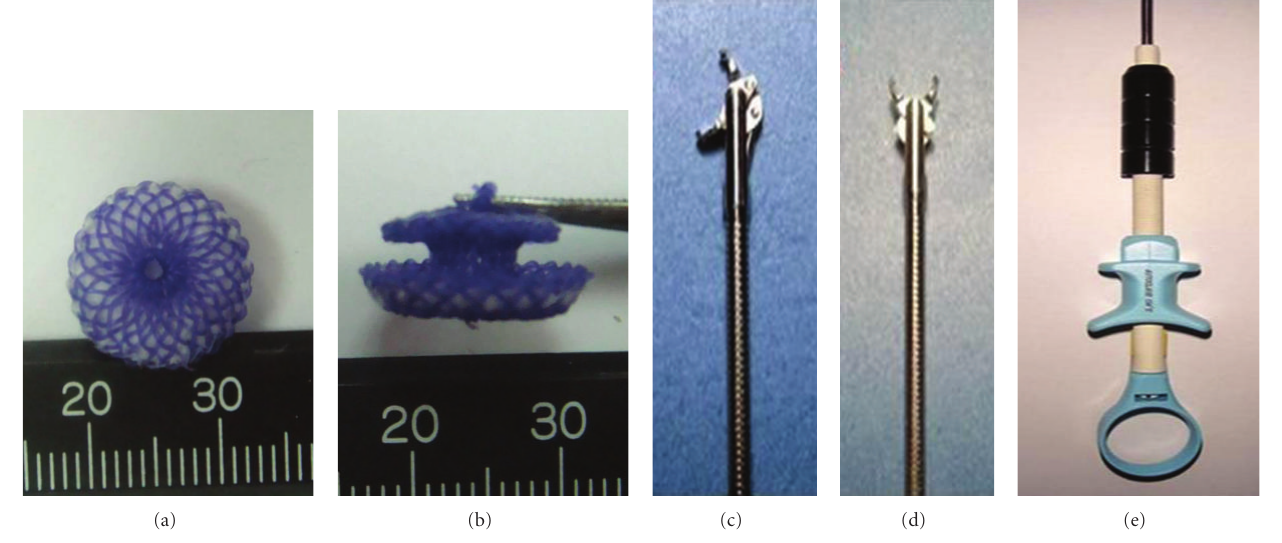
Figure 1: Biodegradable ASD occluder and delivery system. (a) Left atrial view; (b) lateral view, the end of the circular loop picked up by the tweezer; (c) the jaw of the delivery device was designed to be an unstable structure, and it can be opened on both sides according to the force to prevent hook when the occluder was released; (d) the forward opening of the jaw; (e) propeller type manipulated